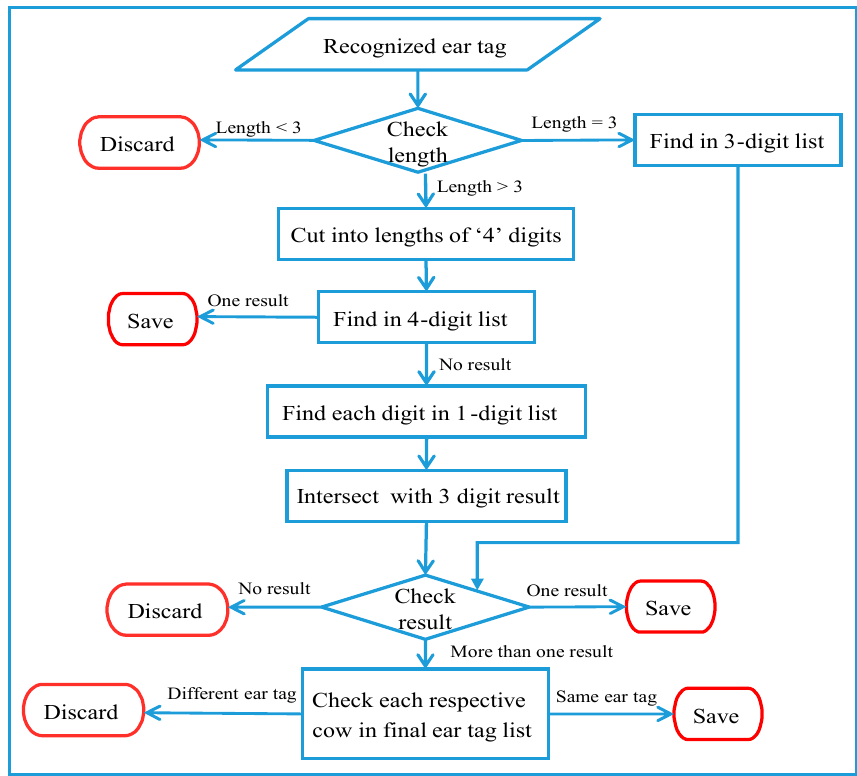
Figure 19. System flow for ear tag confirmation.